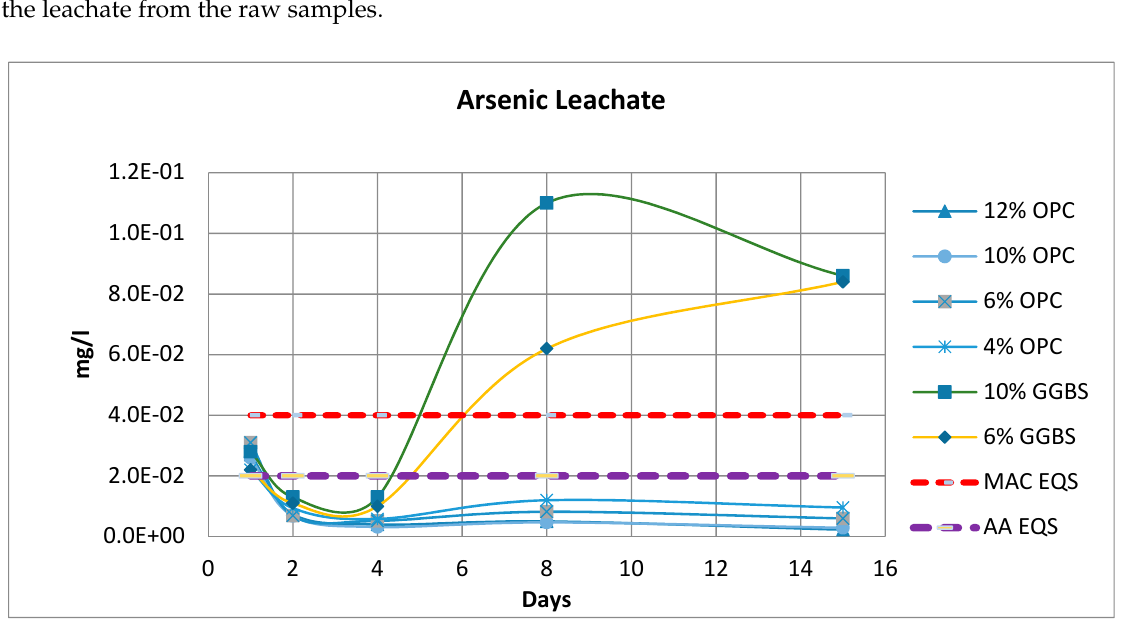
Figure 2. Arsenic leachate from stabilised material.